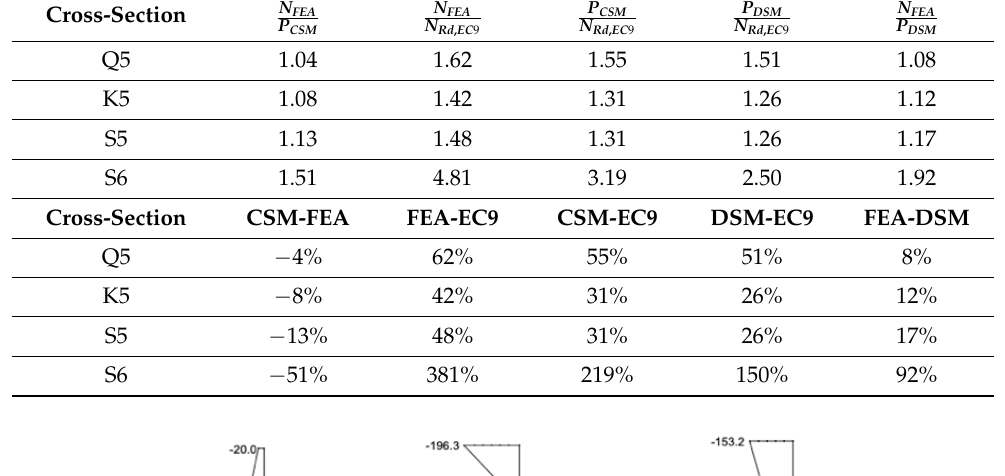
Table A2. Slender cross-sections: comparison between the maximum compressive resistance values: ultimate load ratio and percentage deviation between two methods.